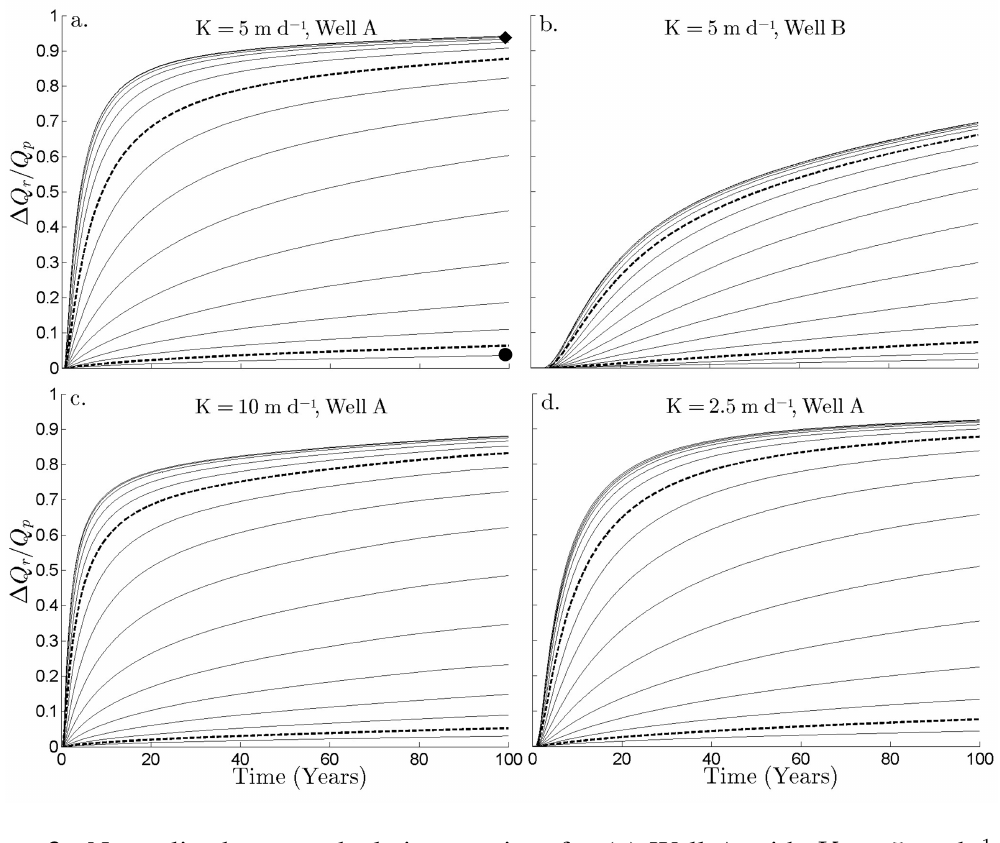
Figure 3. Normalized stream depletion vs. time for ( a ) Well A with K = 5 m d − 1 ; ( b ) Well B with K = 5 m d − 1 ; ( c ) Well A with K = 10 m d − 1 ; and ( d ) Well A with K = 2 . 5